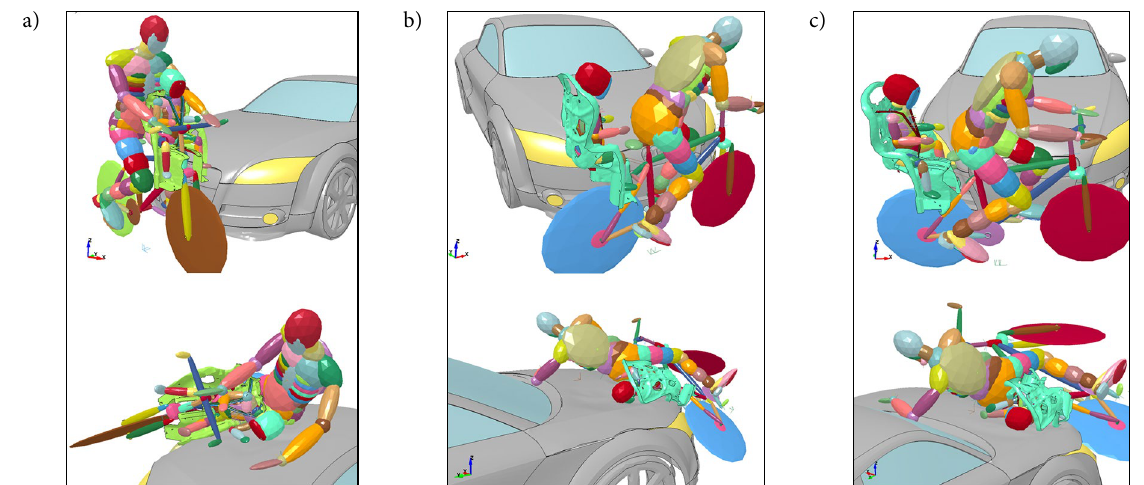
Figure 4. Tandem initial set-up (upper row) and after impact kinematics of dummies in 100 ms (lower row) for: a – front carrier; b – rear-mounted carrier; c – rear-mounted carrier with additional support (the vehicle impacting at 40